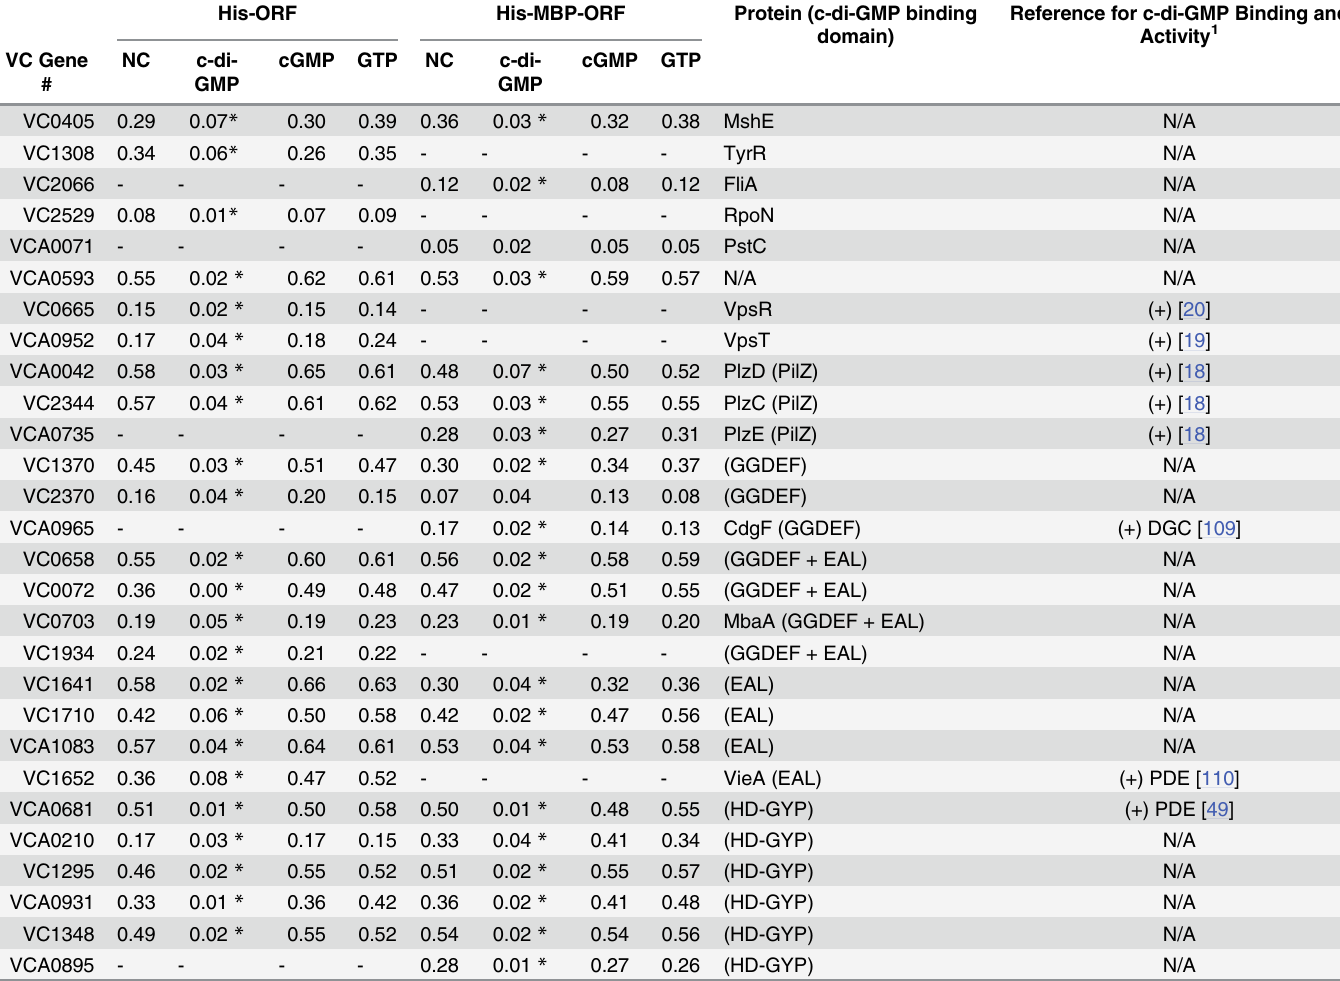
Table 1. Specific binding of validated ORFs to